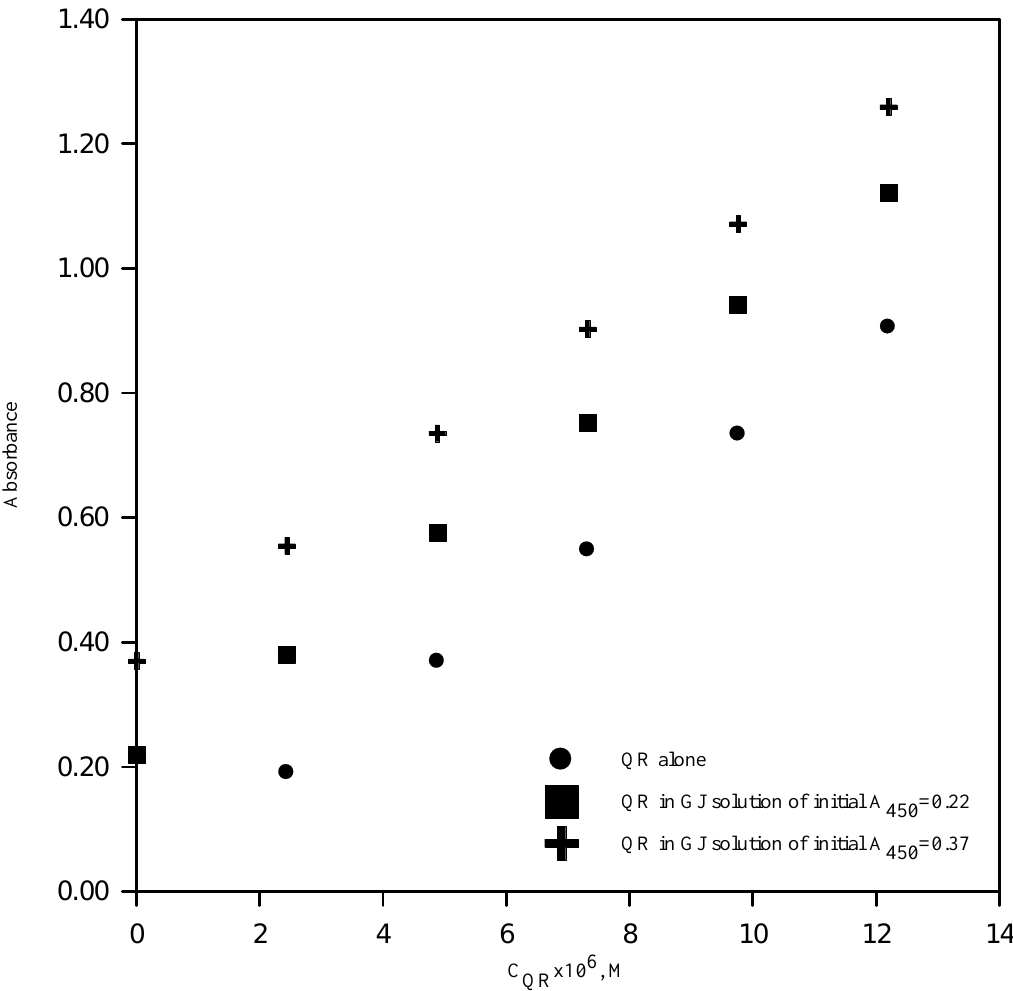
Figure 7. CUPRAC calibration curves of quercetin in grape